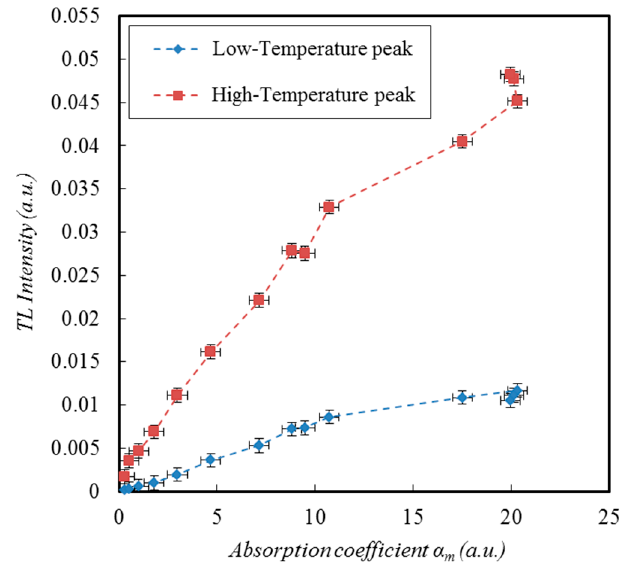
Figure 8. Relationships between the absorption coefficient at about 560 nm wavelength of absorption spectrum and the intensity for each peak on TL glow curve of X-ray irradiated KCl:Eu 2+ (0.04 mol%) single crystals. The dotted lines are to guide the reader’s eye.